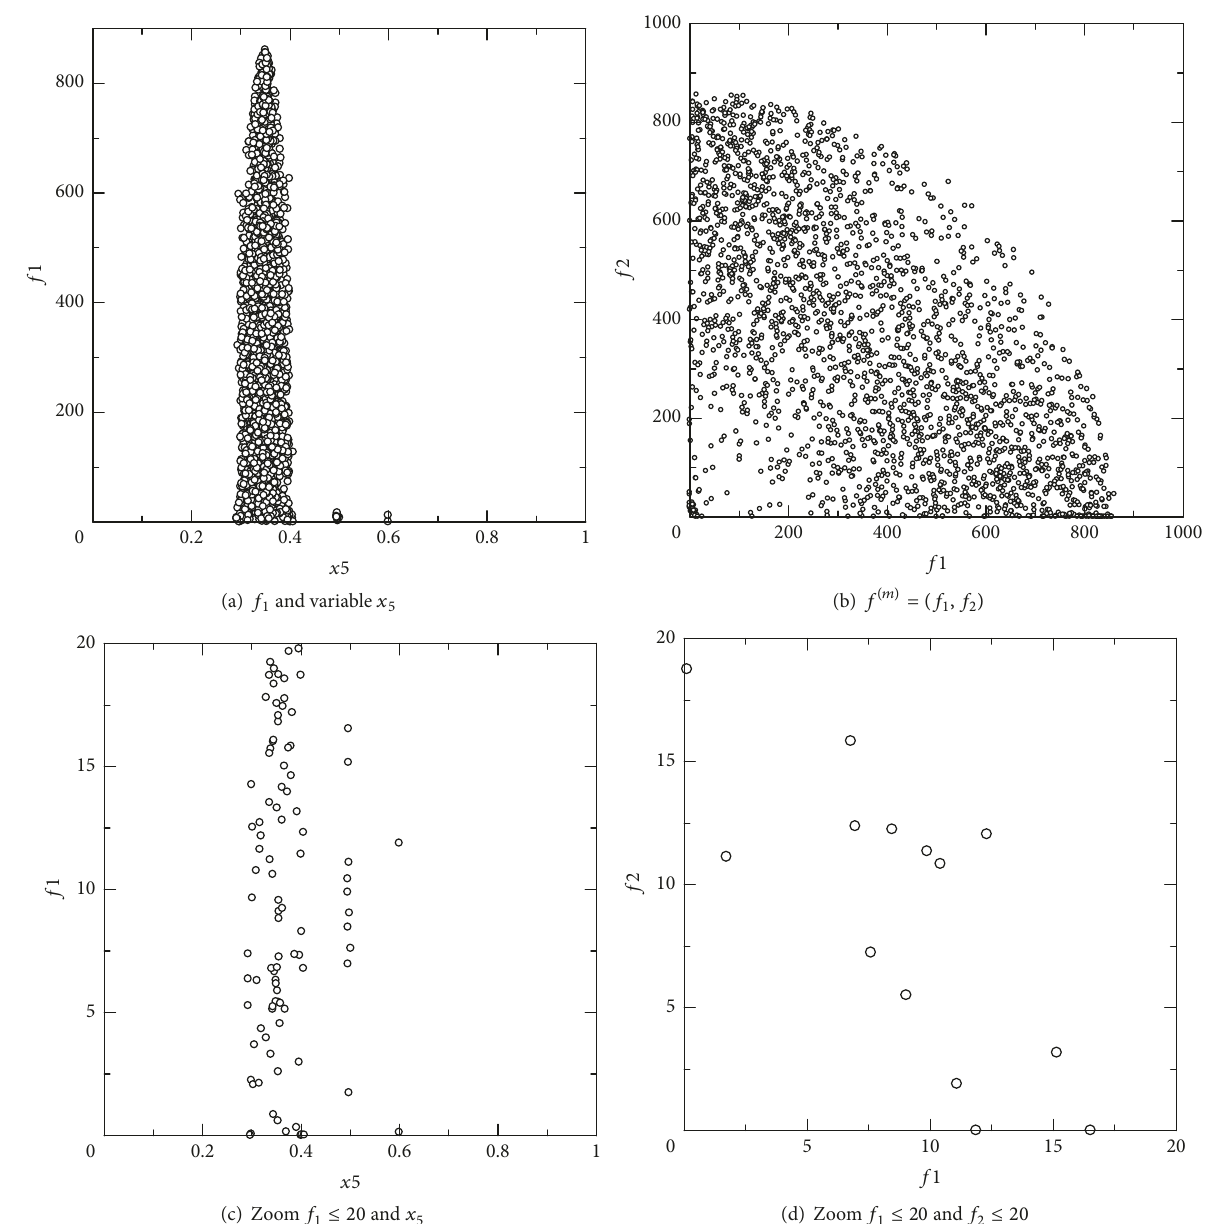
Figure 6: Conventional NSGA-II searching on expanded space f (𝑀) , 𝑀 = 4 . Original space f (𝑚) = (𝑓 1 ,𝑓 2 ) , 𝑚 = 2 , 𝑛 = 5 . Final generation, DTLZ3